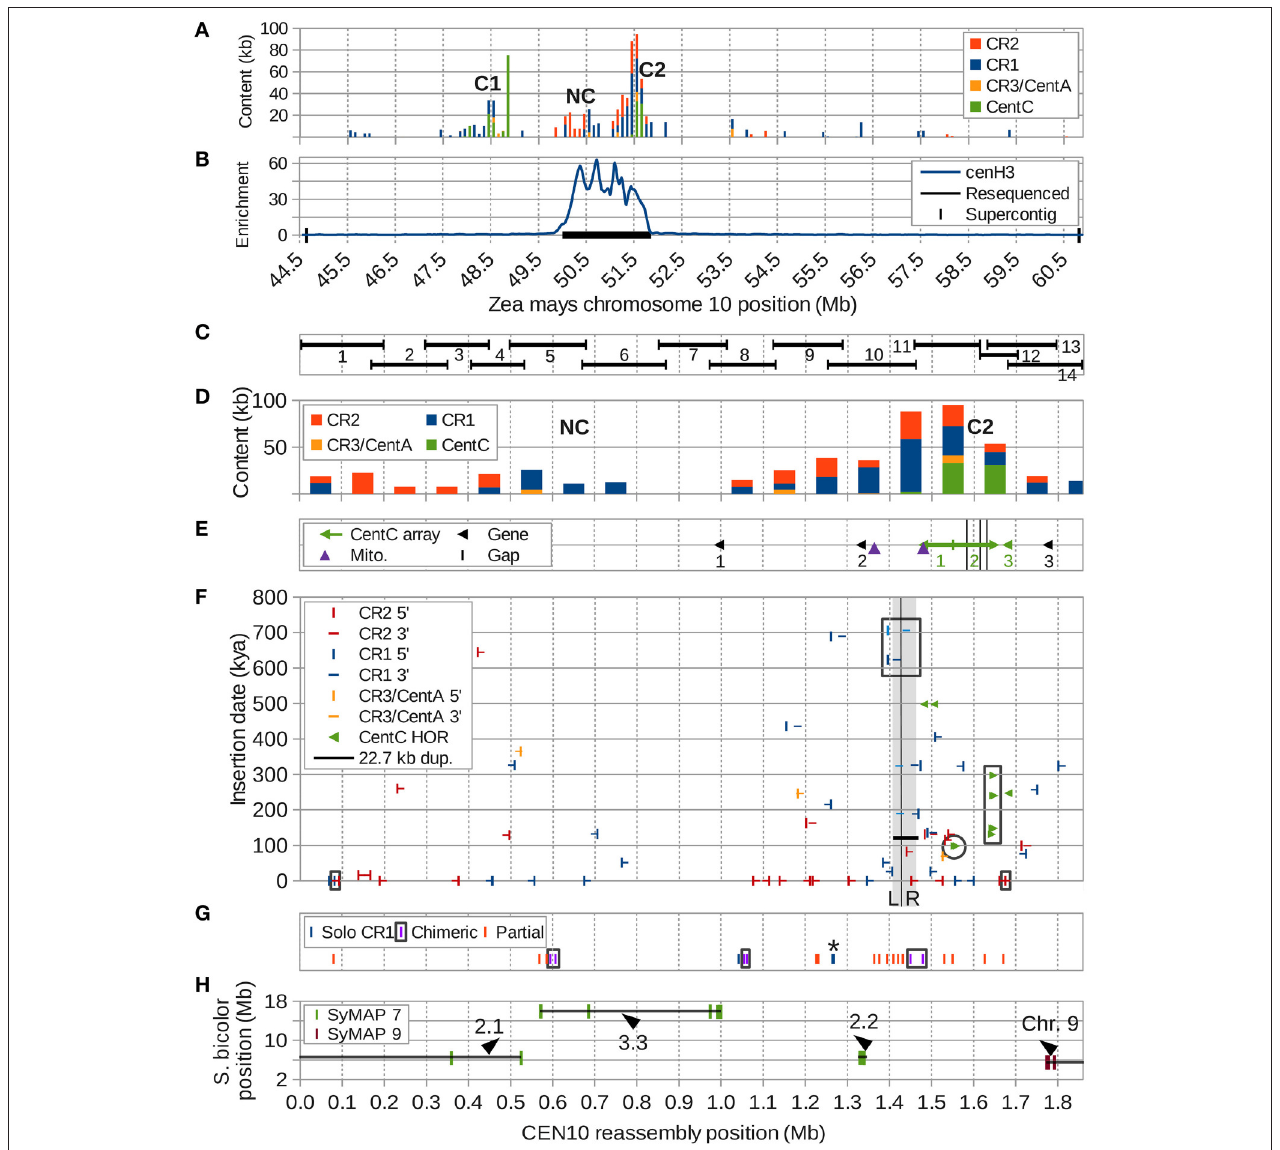
FIGURE 1 | Overview of CEN10 features. (A) Two centromeric repeat clusters containing CentC (C1 and C2) in the CEN10-containing supercontig were split by an ancestral hemicentric inversion and are now separated by a 2.6 Mb region including a CR cluster with no CentC (NC). CR3/CentA means CR3 and CentA (nonautonomous CR3). (B) Enrichment of anti-cenH3 ChIP-seq reveals NC and C2 are in the active centromere. The resequenced region is indicated by the black horizontal bar. (C) The regions of the resequenced CEN10 spanned by each BAC are indicated. (D) Centromeric repeat content per 100 kb window. (E) Positions of the three CentC arrays (#1 and #2 are interrupted by retrotransposons), three transcribed genes (probed by FISH), two mitochondrial insertions and three remaining sequence gaps (black vertical bars within CentC array #2). Arrows indicate the orientation of the CentC arrays; the junction of two adjoining inverted arrays is marked by a vertical bar. Arrowheads indicate direction of transcription for the three genes. (F) Estimated dates of CR element insertion, duplication of the 22.7 kb region (horizontal black line, the duplication is marked by adjacent gray segments labeled “L” and “R” and separated by a vertical black line) and seven higher-order repeats (HORs) of CentC (paired, mostly overlapping, green arrows) are indicated on the y axis. Three CRs with internal recombinations (including a CR partially in the 22.7 kb duplication) are boxed (black). The youngest of the dated CentC HORs ( Figure 5 ) is circled, HORs from Figure 6 are boxed. (G) Positions of recombinant CR sequences, including three solo CR1 LTRs ( * = two solos separated by only 2.3 kb), three chimeric elements (complete but with mismatched TSDs, LTR pairs are boxed) and 14 partial CR elements. For clarity, only the two closest ends of a chimeric element located in the 22.7 kb duplication are shown. A partial CR1 that may be artificially truncated by BAC (#12) vector is shown at position 1.63 Mb. (H) Synteny markers shared with sorghum chromosomes 7 (SyMAP 7) and 9 (SyMAP 9) are indicated by their sorghum and maize coordinates with orientation of blocks (lines) indicated by arrowheads. The most downstream marker cluster of the second synteny block (at 1 Mb) is inverted relative to sorghum, but co-linear with Brachypodium and rice. The 1.85 Mb CEN10 is composed of four different syntenic segments from two different sorghum chromosomes indicated here with labels as described in Figure 7 and Supplemental Figure S10.